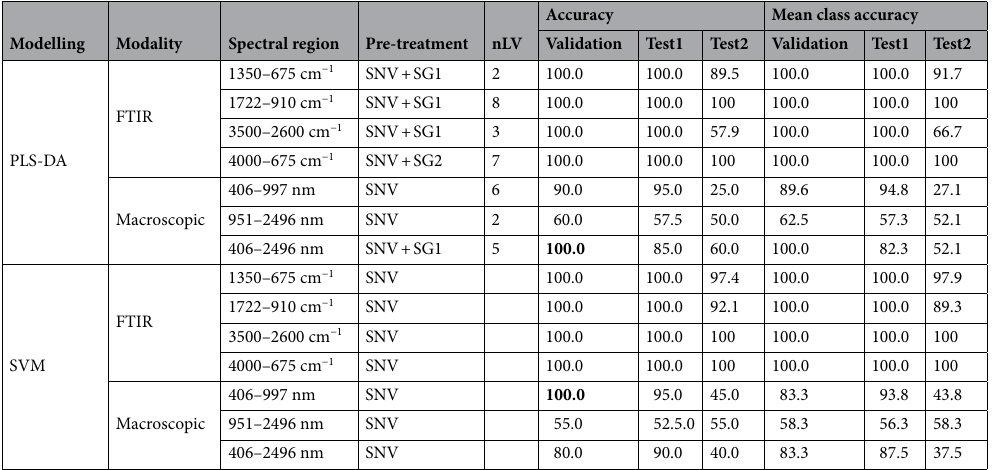
Table 2. Model performances for discrimination between Gram-positive and Gram-negative types based on mean spectra. For each modality/spectral region, the model yielding maximum accuracy in the validation set is bolded.